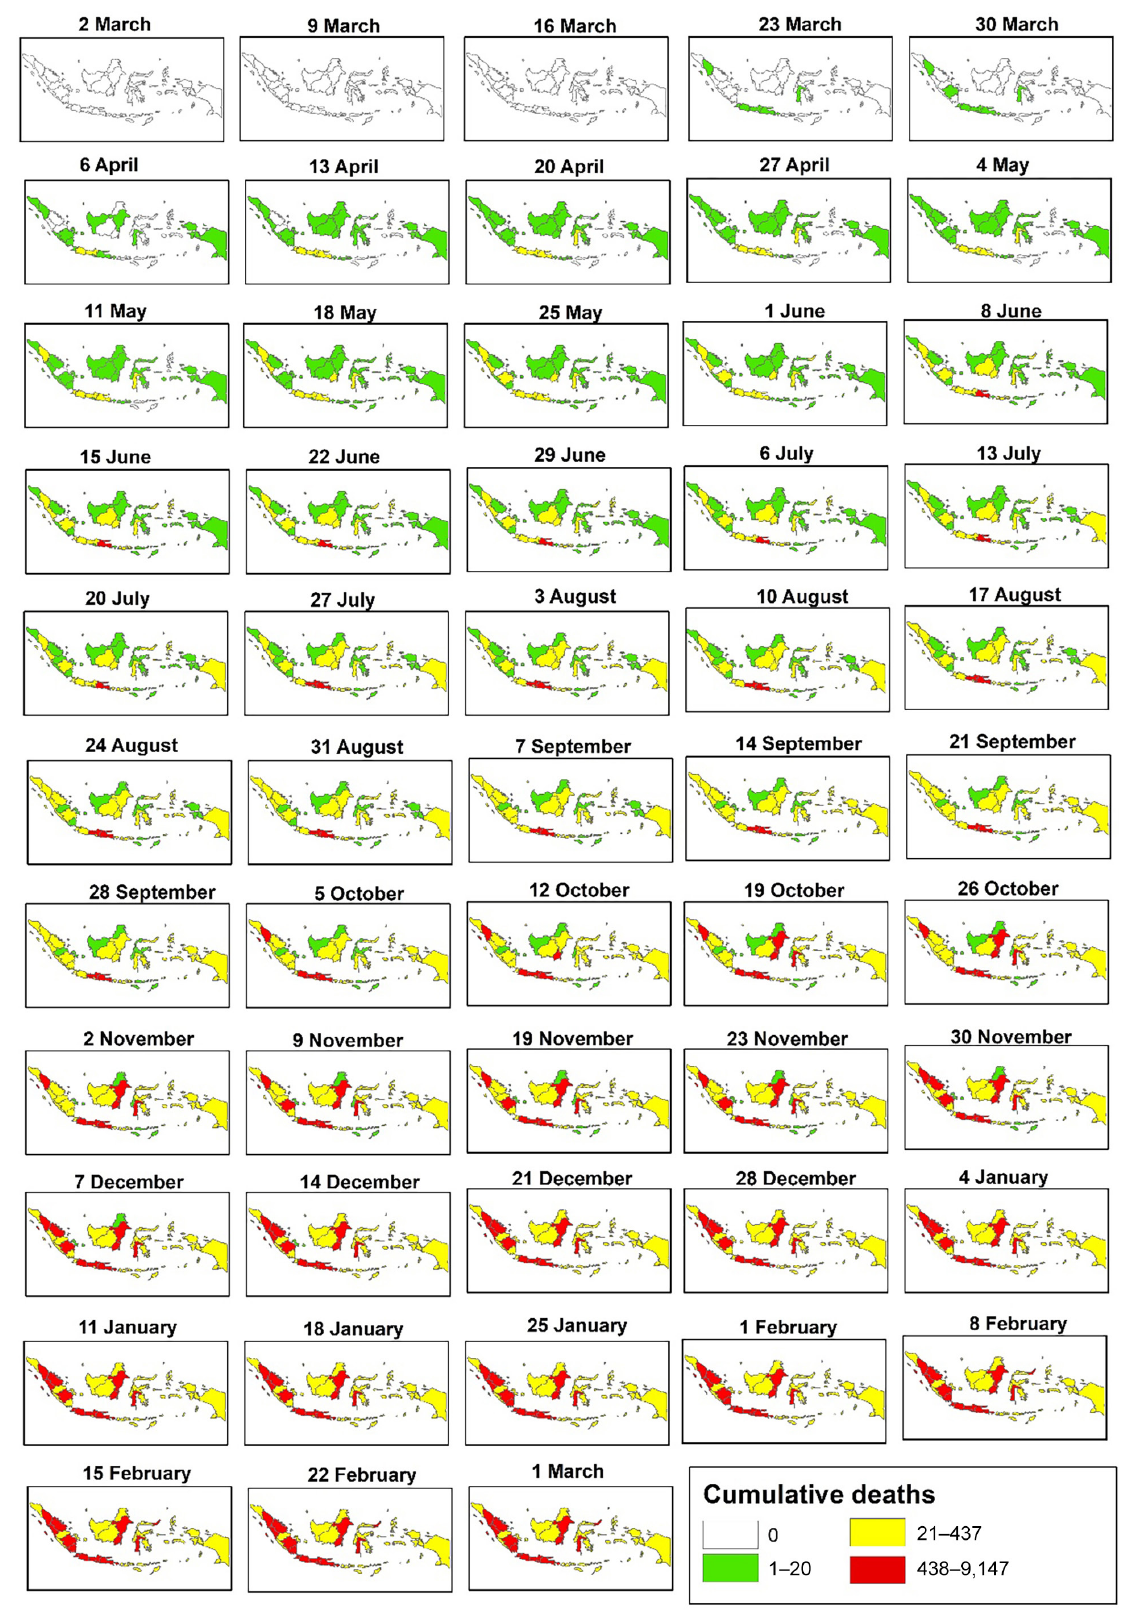
Fig. 4. Death cases from COVID-19 between March 2020 and March 2021. Source: own